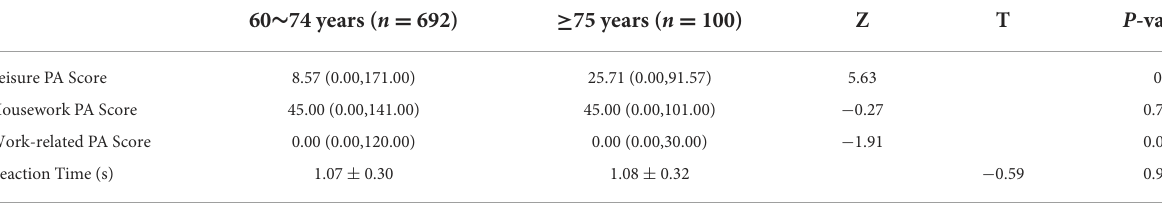
TABLE 2 Comparison of PASE score and reaction time in participants of different ages.